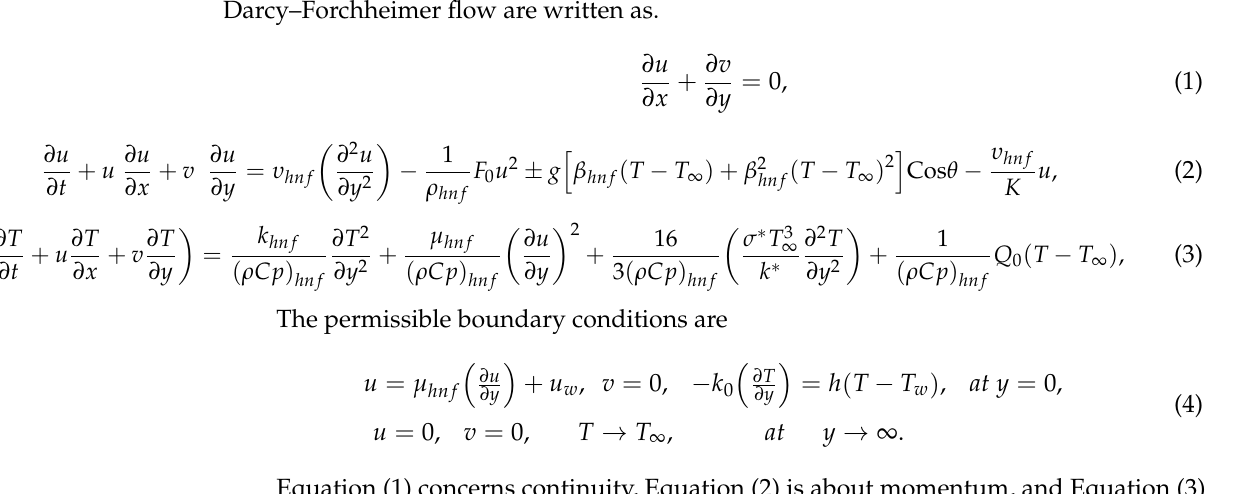
and Cu Al O ) and base fluid ( H O ) 2 3 2 T is w